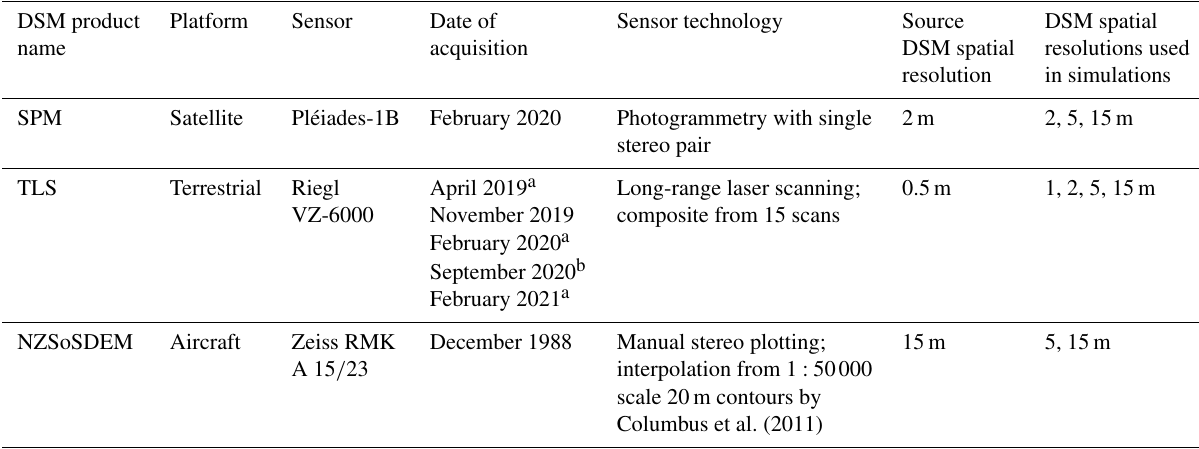
Table 1. Description of the digital surface models (DSMs) used in RAMMS simulations and their derivations. DSM product Platform